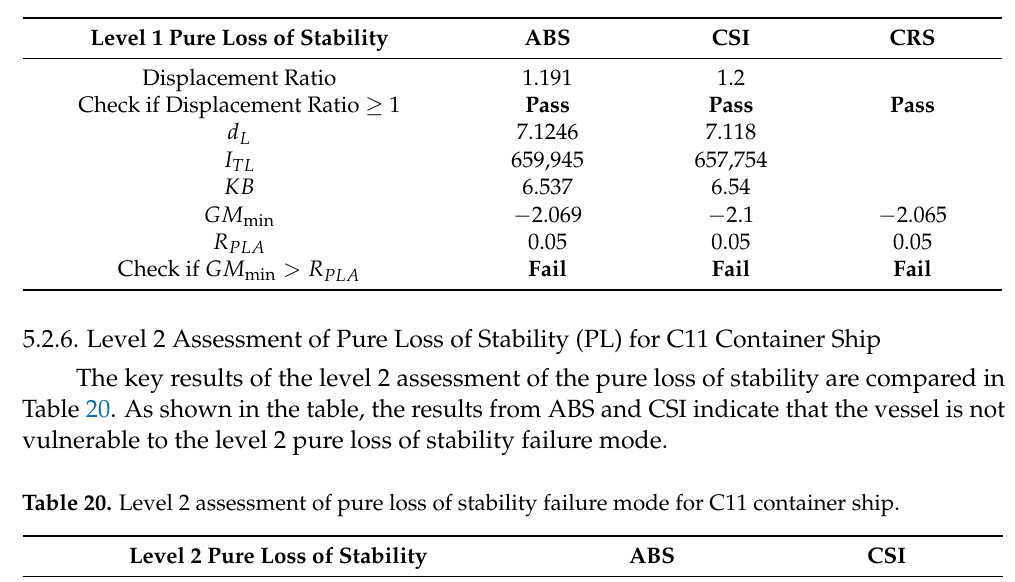
Table 19. Level 1 assessment of the pure loss of stability failure mode for the C11 container ship.